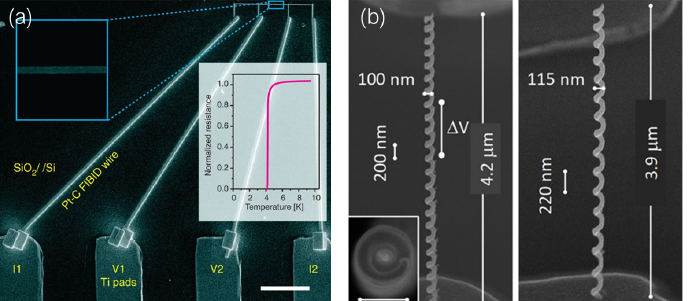
Figure 3. ( a ) Superconducting in-plane W-C nanowire (50 nm in width), nanopatterned by Ga + FIBID. Scale bar: 5 µ m. Reprinted from [65], with permissions from Springer Nature. ( b ) Superconducting 3D W-C nanohelices nanopatterned by He + FIBID. Scale bar in inset: 100 nm. Reprinted from [30] with permissions from ACS Publications (https://pubs.acs.org/doi/abs/10.1021/acs.nanolett.9b03153, accessed on 15 March 2022). Further permissions related to the material excerpted should be directed to the